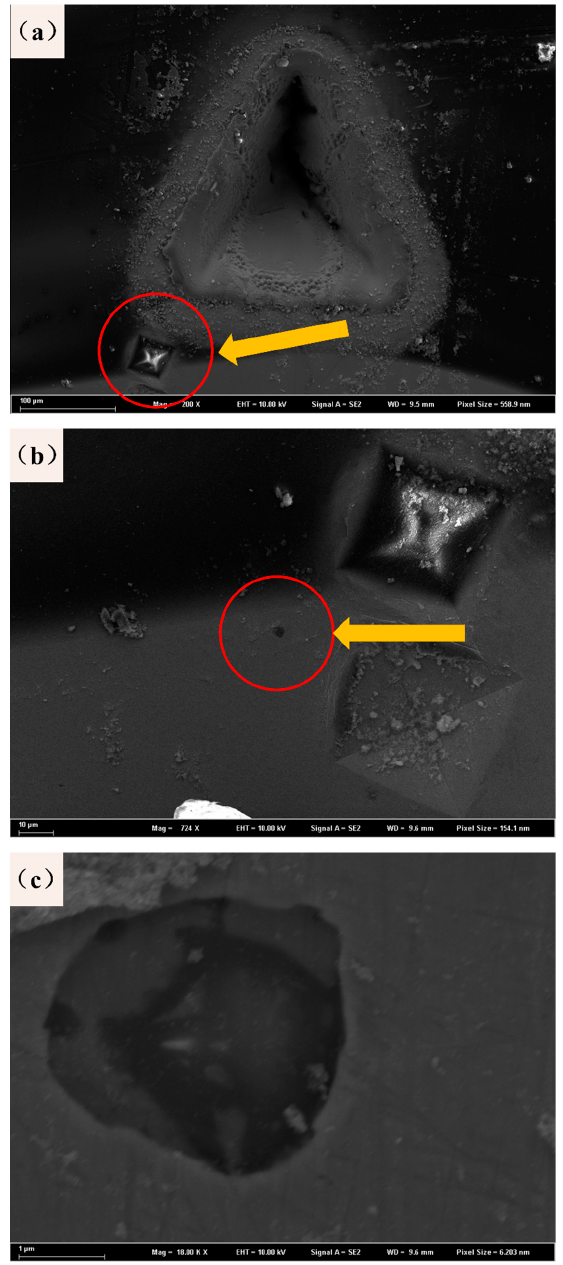
Figure 3. SEM images of the laser-prefabricated defects: ( a ) overall rendering, ( b ) indentation rendering, and ( c ) inclusion rendering.